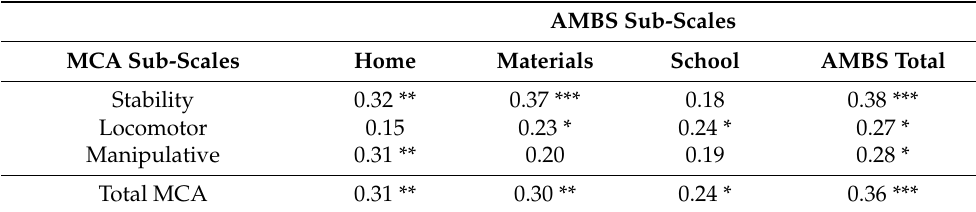
Table 2. Correlation between the MCA (sub-scales and total) and AMBS (sub-scales and total).